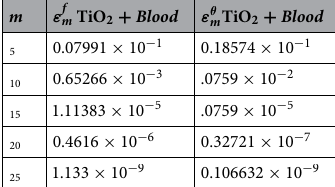
Table 8. Convergence of OHAM for TiO 2